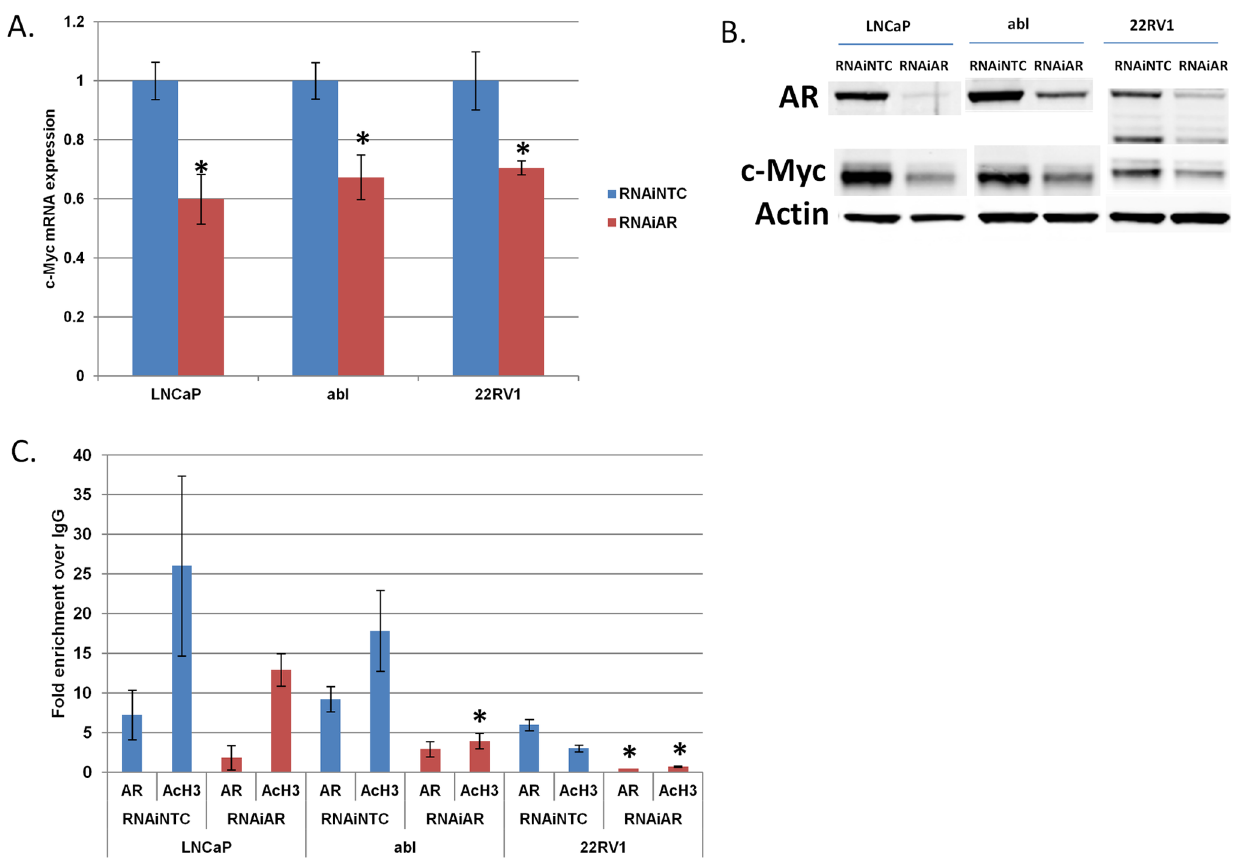
Figure 4. AR promotes ligand-independent expression of c-Myc . LNCaP, abl and 22RV1 cells were transfected with 50 nM of non-targeted control (NTC) or AR RNAi oligonucleotides. Cells were then grown in charcoal-stripped serum for 96 hours. At the end of the treatment, cells were harvested to extract mRNA and protein. A) QRT-PCR was performed to determine the levels of c-Myc relative to actin . B) Immunoblotting was performed to determine the levels of AR, c-Myc and actin. C) Parallel treatments were performed and cells were cross-linked and processed for ChIP to determine AR and histone H3 acetylation (AcH3) enrichment at the c-Myc enhancer. *denotes p , 0.05 compared to NTC.